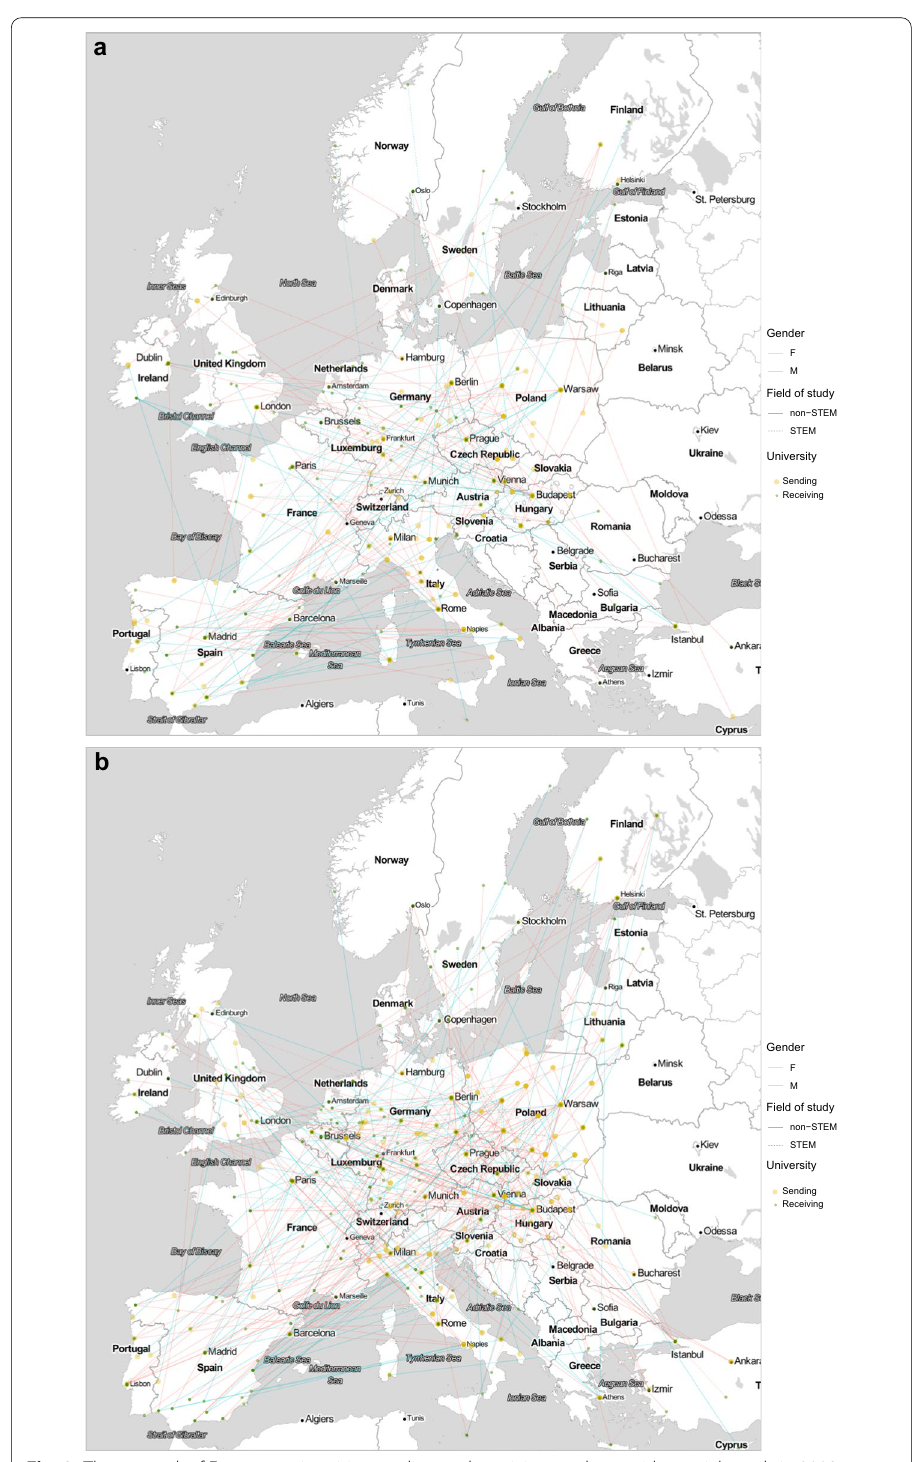
Fig. 3 The network of Erasmus universities sending and receiving students with special needs in 2008 ( a ) and 2013 ( b ). Yellow (Green) dots represent sending (receiving) universities. Red (Cyan) links represent flows of female (male) Erasmus students. Continuous (dashed) links represent flows of students enrolled in non-STEM (STEM)